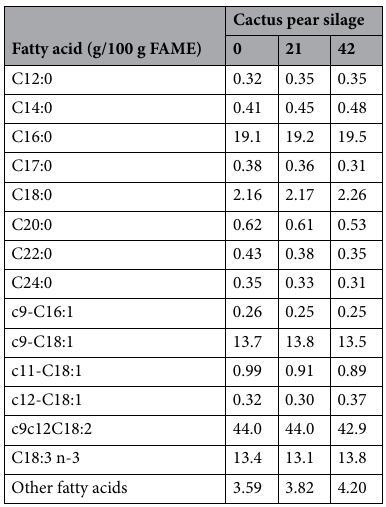
Table 11. Fatty acid (g/100 g FAME) composition of experimental diets with cactus pear silage.